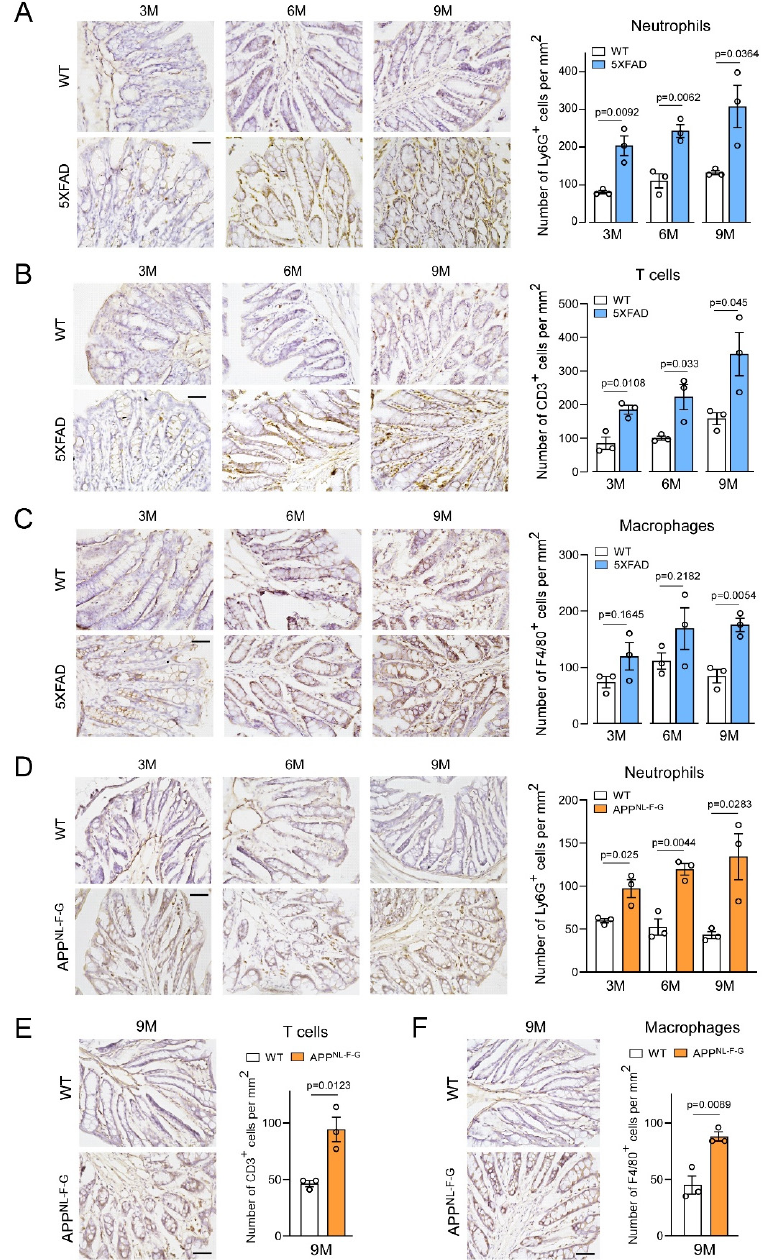
Figure 4. Immune cell infiltration into AD mouse model colons. ( A ) Neutrophil, ( B ) T cell, and ( C ) macrophage infiltration into WT and 5XFAD mouse colons at 3 (3M), 6 (6M), and 9 (9M) months were examined via the immunohistochemical staining of specific immune cell markers using anti-Ly6G, anti-CD3, and anti-F4/80 antibodies ( n = 3 mice/group. Scale bar =20 μ m). Similarly, immune cell infiltration into WT and APP NL-F-G mouse colons at different ages were determined via immuno- histochemical staining using anti-Ly6G, anti-CD3, and anti-F4/80 antibodies in ( D ), ( E ), and ( F ), respectively. ( n = 3 mice/group. Scale bar = 20 μ m). Quantified immune cell numbers/mm 2 are shown. Data were expressed as the mean ± standard error of the mean and compared using unpaired Student’s t -tests.